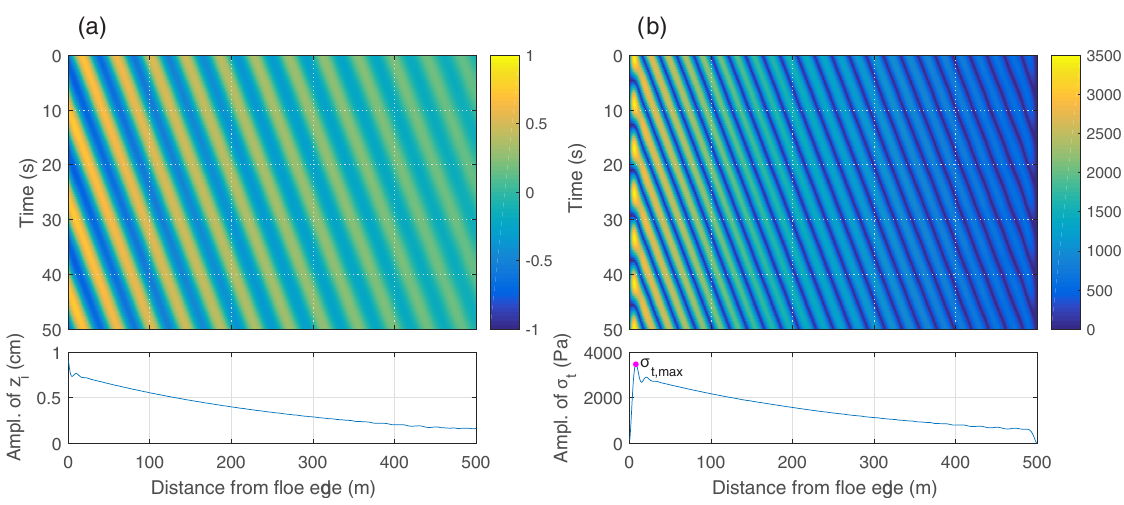
Figure 4. Simulated space–time variability of the ice vertical displacement z i (a) in centimeters and the tensile stress σ t (b) in Pa for an ice floe with length L o = 500m, ice thickness h i = 0 . 5m, and open-water wavelength L w , 0 = 42m. Lower diagrams show the amplitude of z i and σ t in function of the distance from the ice edge. Magenta dot in panel (b) marks σ t , max .